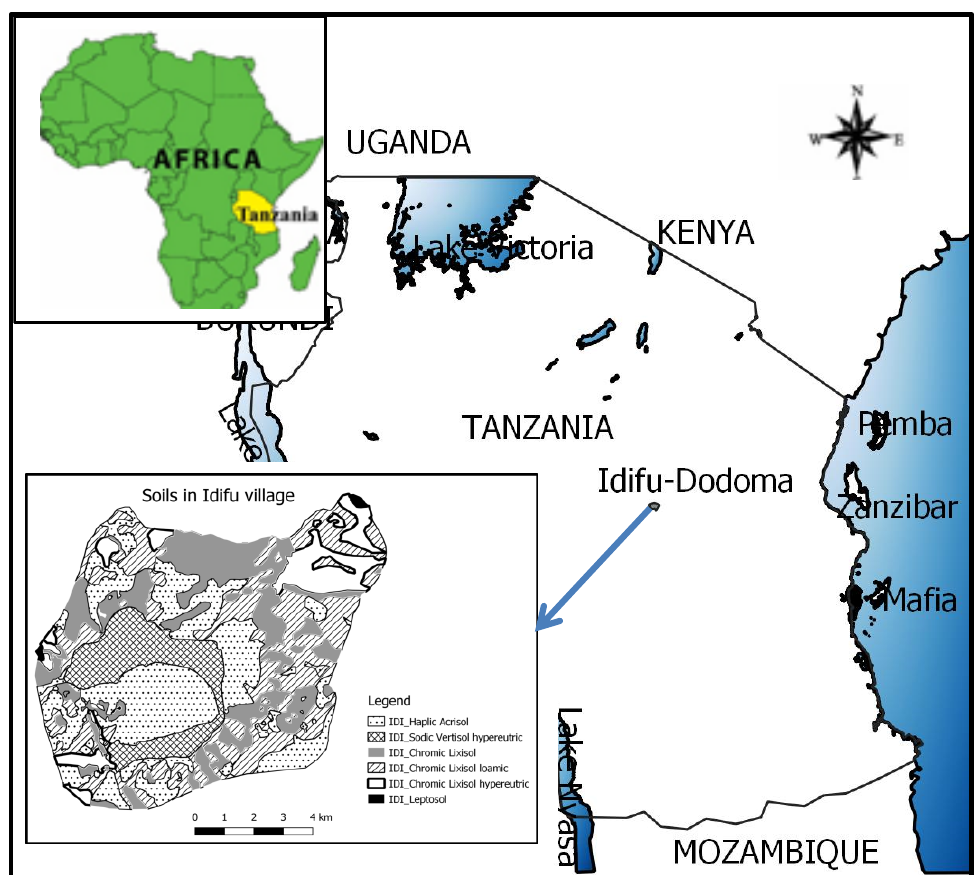
Figure 1. Location of the study site and soil distribution (Modified from [10]).